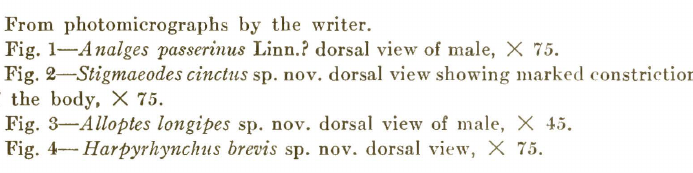
Fig. 2-Stigmaeodes cinctus sp. nov. dorsal view showing marked constriction of the body, X 75. Fig. 3-Alloptes longipes sp. nov. dorsal view of male, X -t5. Fig. 4-Harpyrhynchus brevis sp. nov. dorsal view, X